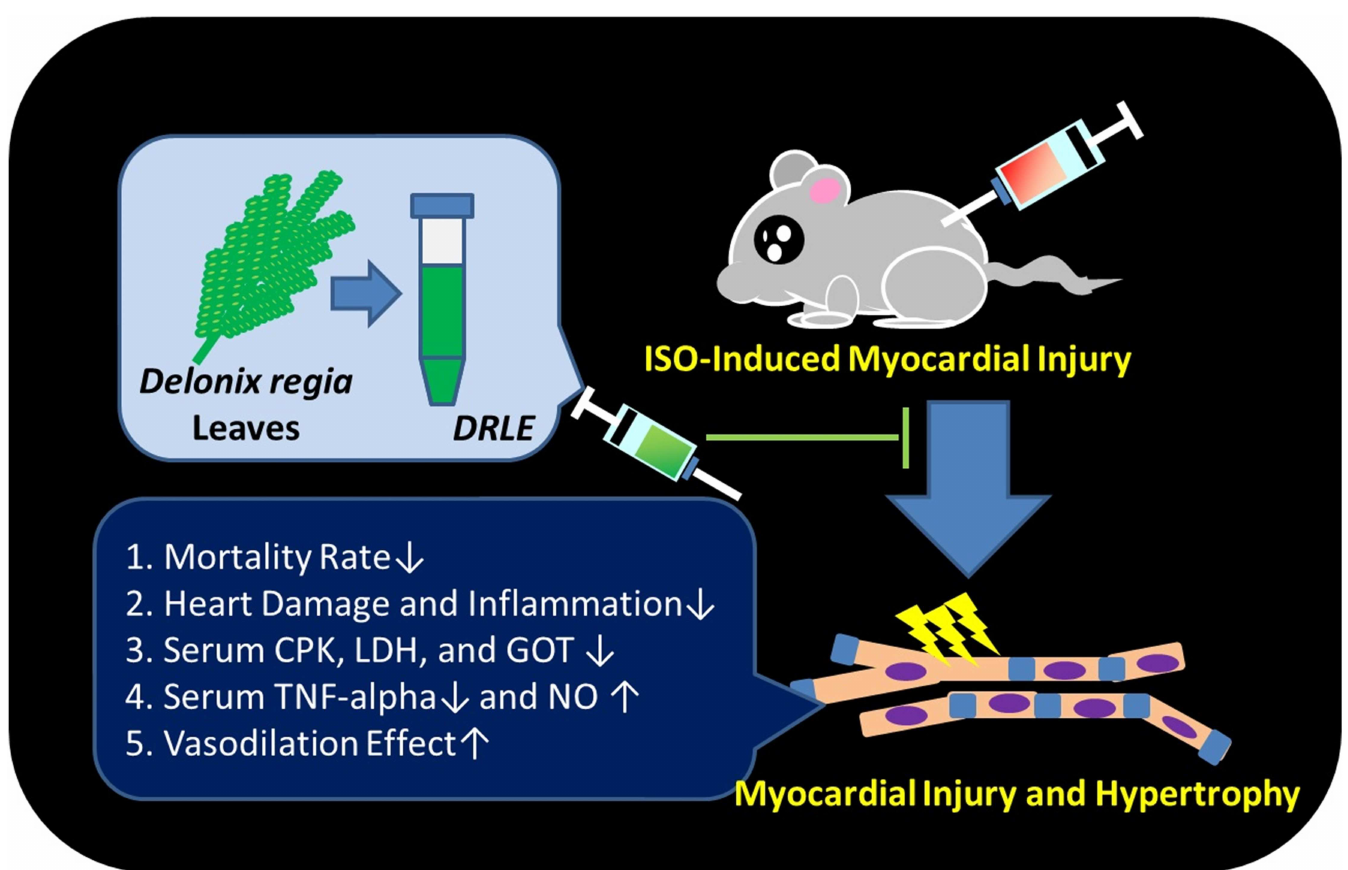
Fig 7. Cardioprotective effect of DRLE. In this study, we found that DRLE can reduce the mortality rate, cardiachypertrophyand heart injury in ISO- injured mice. Serum CPK, LDH, GOT, and TNF-alphawere also reducedby DRLE administration. Serum NO levels were inducedby ISO injectionin mice in vivo , and had the vasodilatory effects in vitro